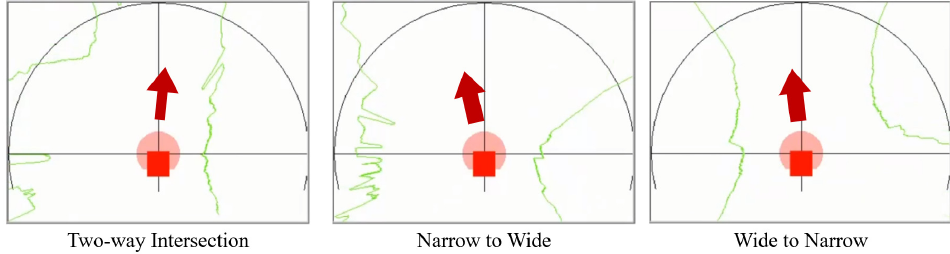
Figure 8. Tunnel shape obtained from LiDAR sensor in two-way intersection, narrow-to-wide, and wide-to-narrow sections.